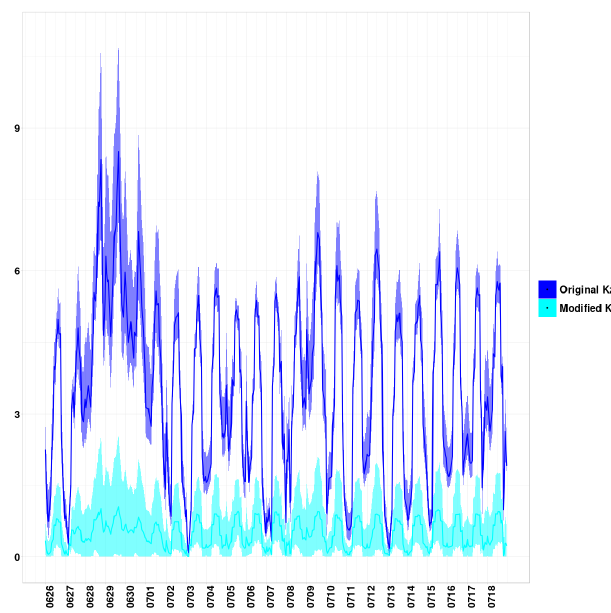
Figure 5. Changes in K z (m 2 s − 1 ) between the first and second model layer in test cases without any modifications and the test case in which the K z corrections are applied. The lines are for the grid cell corresponding to the Salles-Bilos site, and the envelope corre- sponds to grid cells in the 11km × 11km area surrounding the site. The reasoning for showing 11km × 11km is given in Sect.